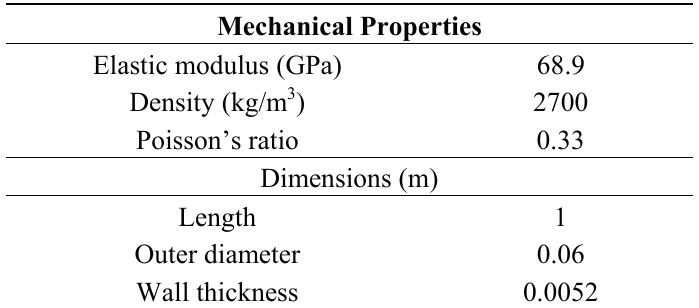
Table 1. Dimensions and mechanical properties of the aluminum pipe.